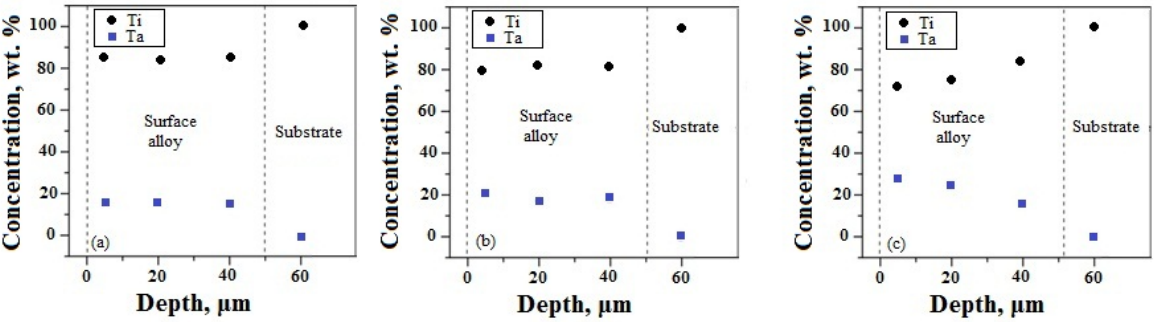
Figure 3. Elemental distribution within the Ti-Ta coatings obtained after the ( a ) first cycle; ( b ) second cycle; and ( c ) third cycle.